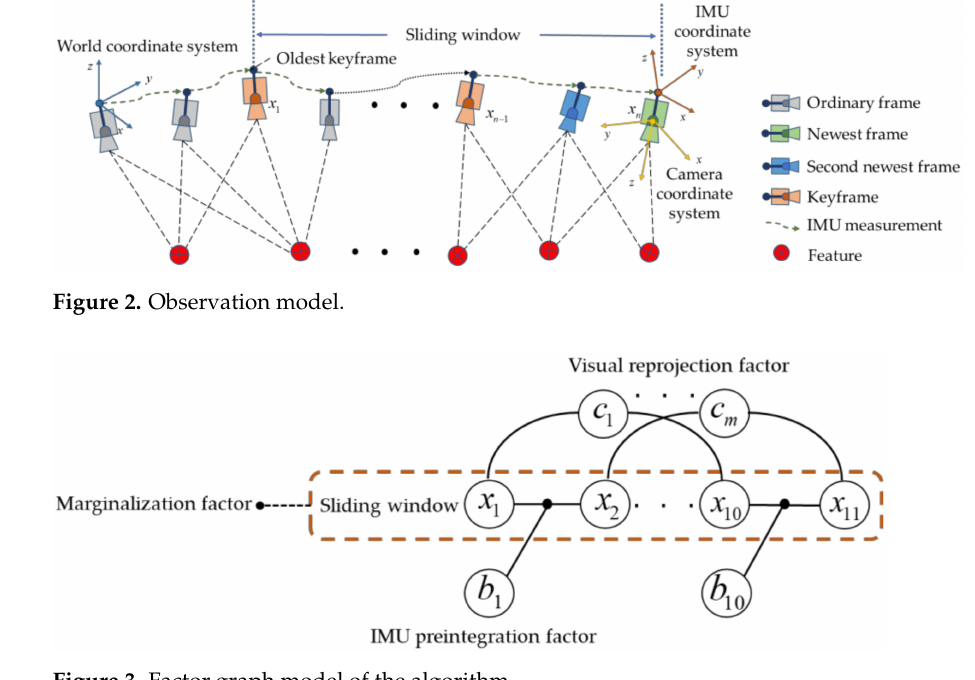
Figure 3. Factor graph model of the